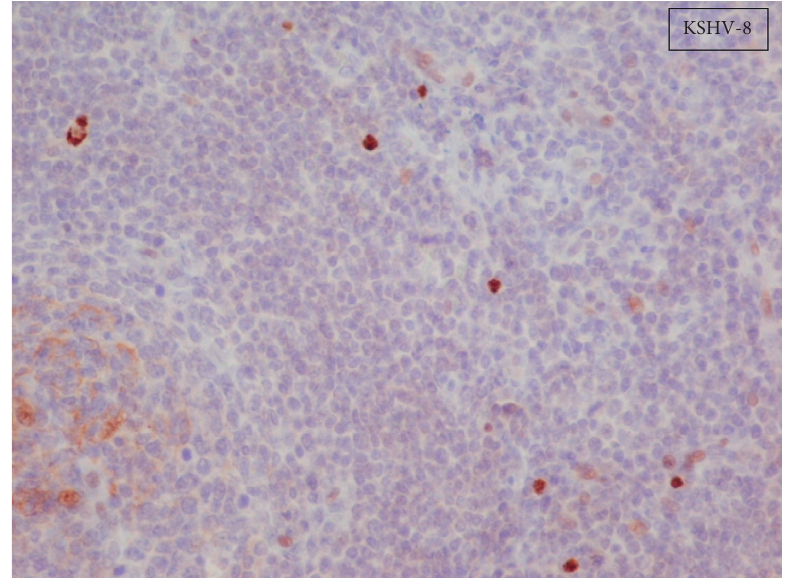
Figure 3: HHV-8 immunohistochemical stain, original magnification × 40. Cells with plasmablastic morphology are HHV8-infected cells (brown nuclei). These cells were polytypic (immunostaining for kappa and lambda light chains (data not shown)). In order to exclude the possibility of random positive counting, the immunostaining section was split into four fields and cells positive for HHV8 were counted in each of these four quartiles. The measurements were grouped for each quartile. Pairwise comparisons among groups using the student t test showed p values > 0.05 in all cases. In addition, repeating procedures concerning immunohistochemical staining for HHV8 were performed in other two different histological sections producing finally similar